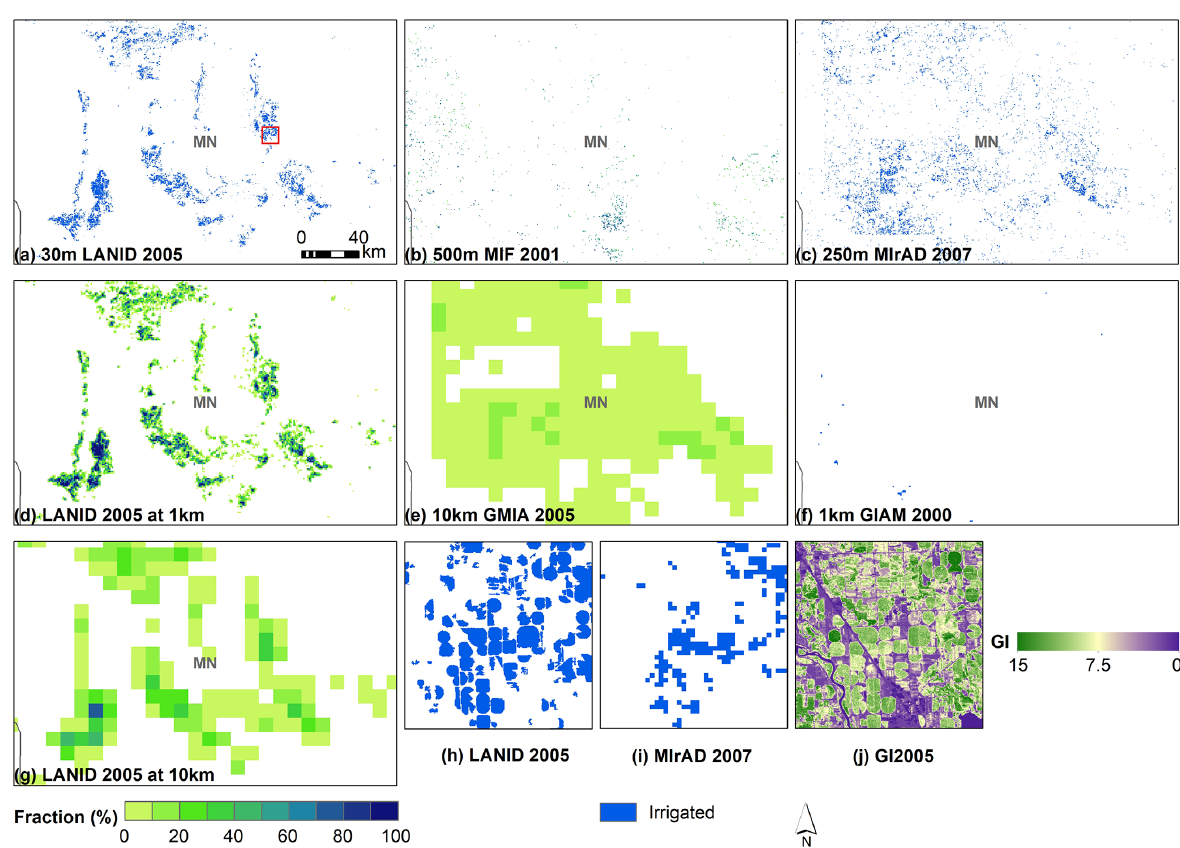
Figure 13. Product comparison in central Minnesota. In addition to the original 30m LANID (a) , the map is aggregated to 1 and 10km resolution for panels (d) and (g) . Panels (h–i) show the location highlighted in (a) (red